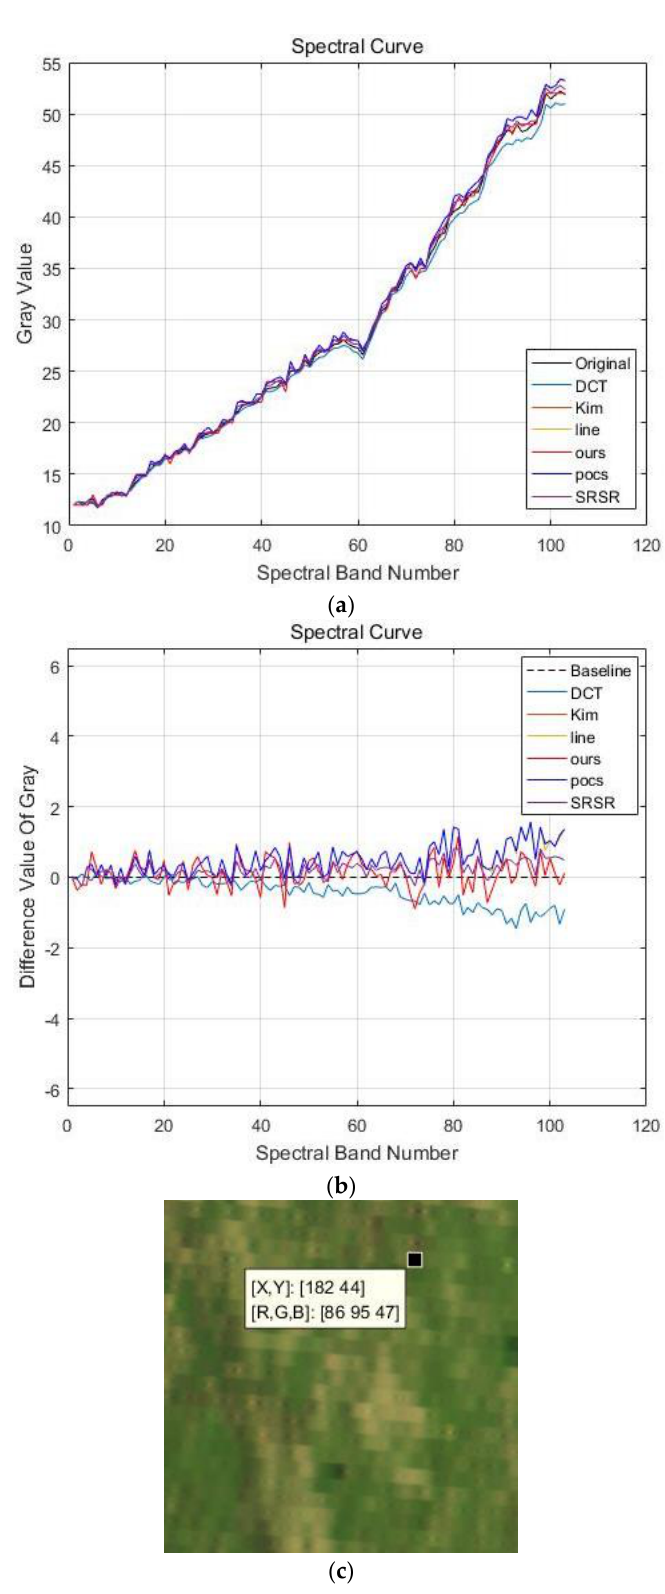
Figure 12. Spectral curves of pixel (182, 44) in the Jinyin Tan dataset 2. ( a ) Spectral curves of different methods; ( b ) Difference values of spectral curves (the black dotted line is the baseline, the red line shows the results of the proposed methods); ( c ) spectral curve location.